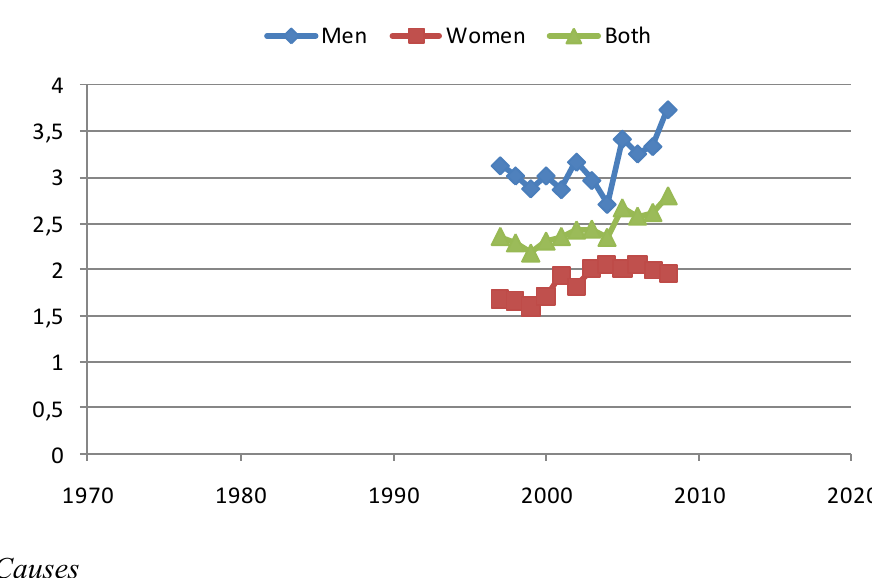
Figure 10. The mortality in melanoma starts to increase again after 2005 for men in